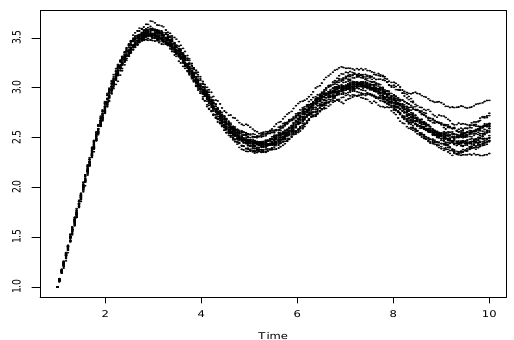
Figure 2. Simulated sample paths for the oscillabolastic Gaussian process. Parameters: κ = 2.5, α = − 2, β = 1.5, γ = 1, θ = 0.5 and σ 2 =